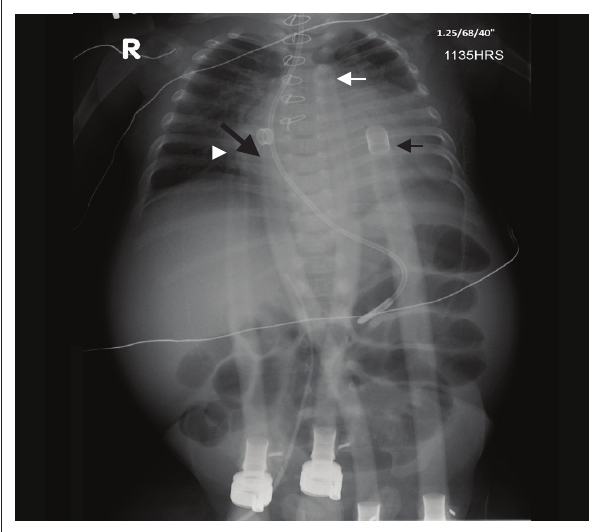
FIGURE 7: An accurately positioned HMII left ventricular assist device in a 67-year-old male with ischaemic cardiomyopathy. Note that the inflow cannula (black arrow) angle is 72° and the left ventricular assist device is placed at pump pocket depth (left brace) of 11 cm. Note the other parts of the HMII left ventricular assist device – the bell-shaped impeller unit (star), the outflow cannula (arrow head) and the driveline (white arrow).